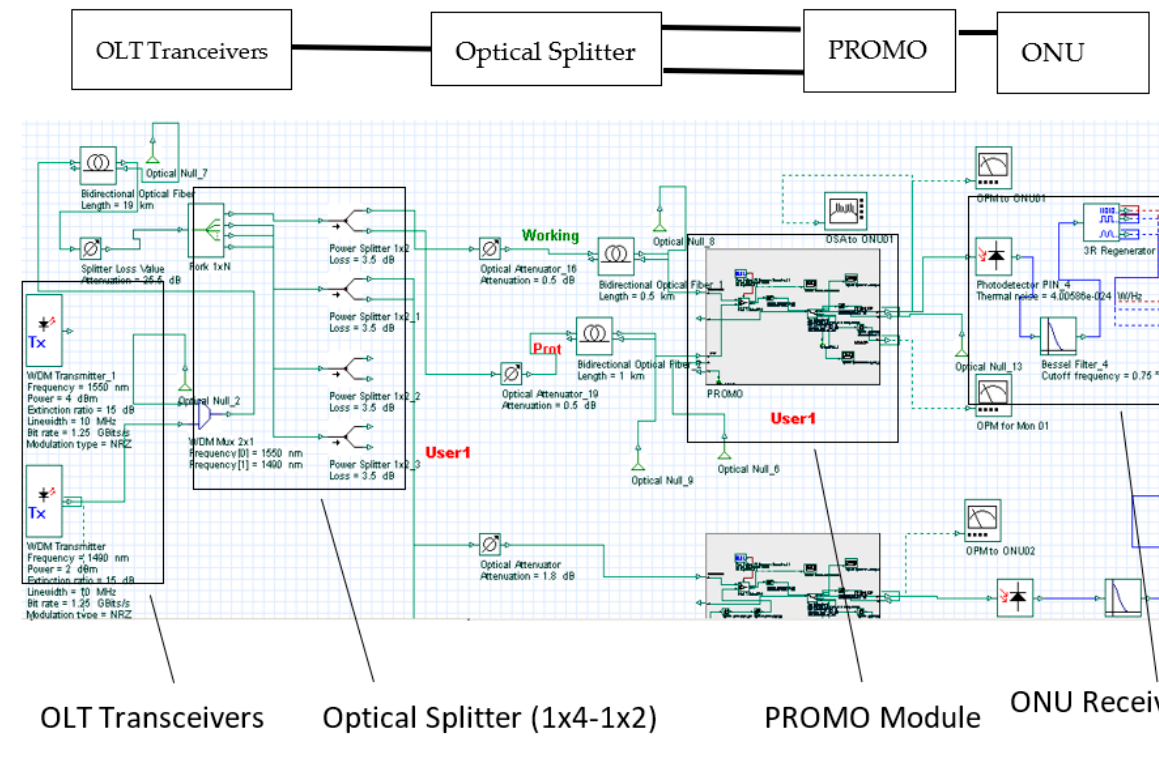
Figure 8. Simulation arrangement.